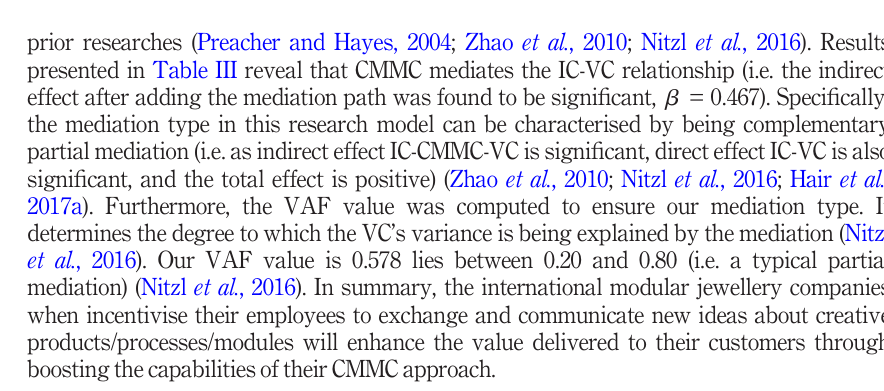
Table III. The direct, indirect and total effects in the